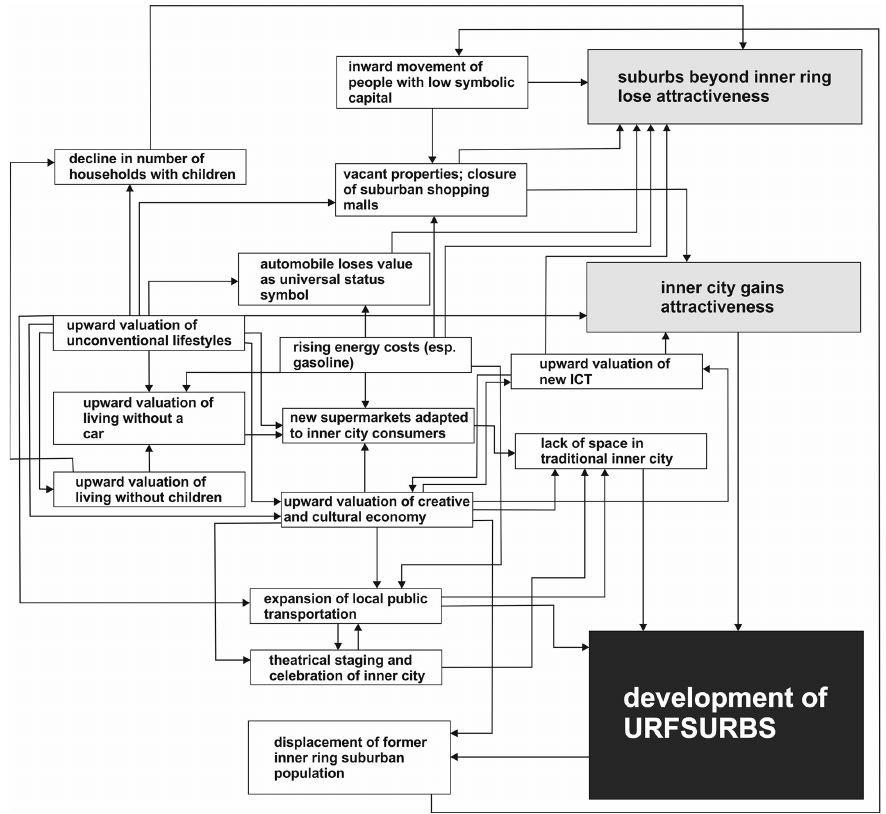
Fig. 6. URFSURBS development processes and their interrelations. Source: Kühne 2016; Kühne et al.